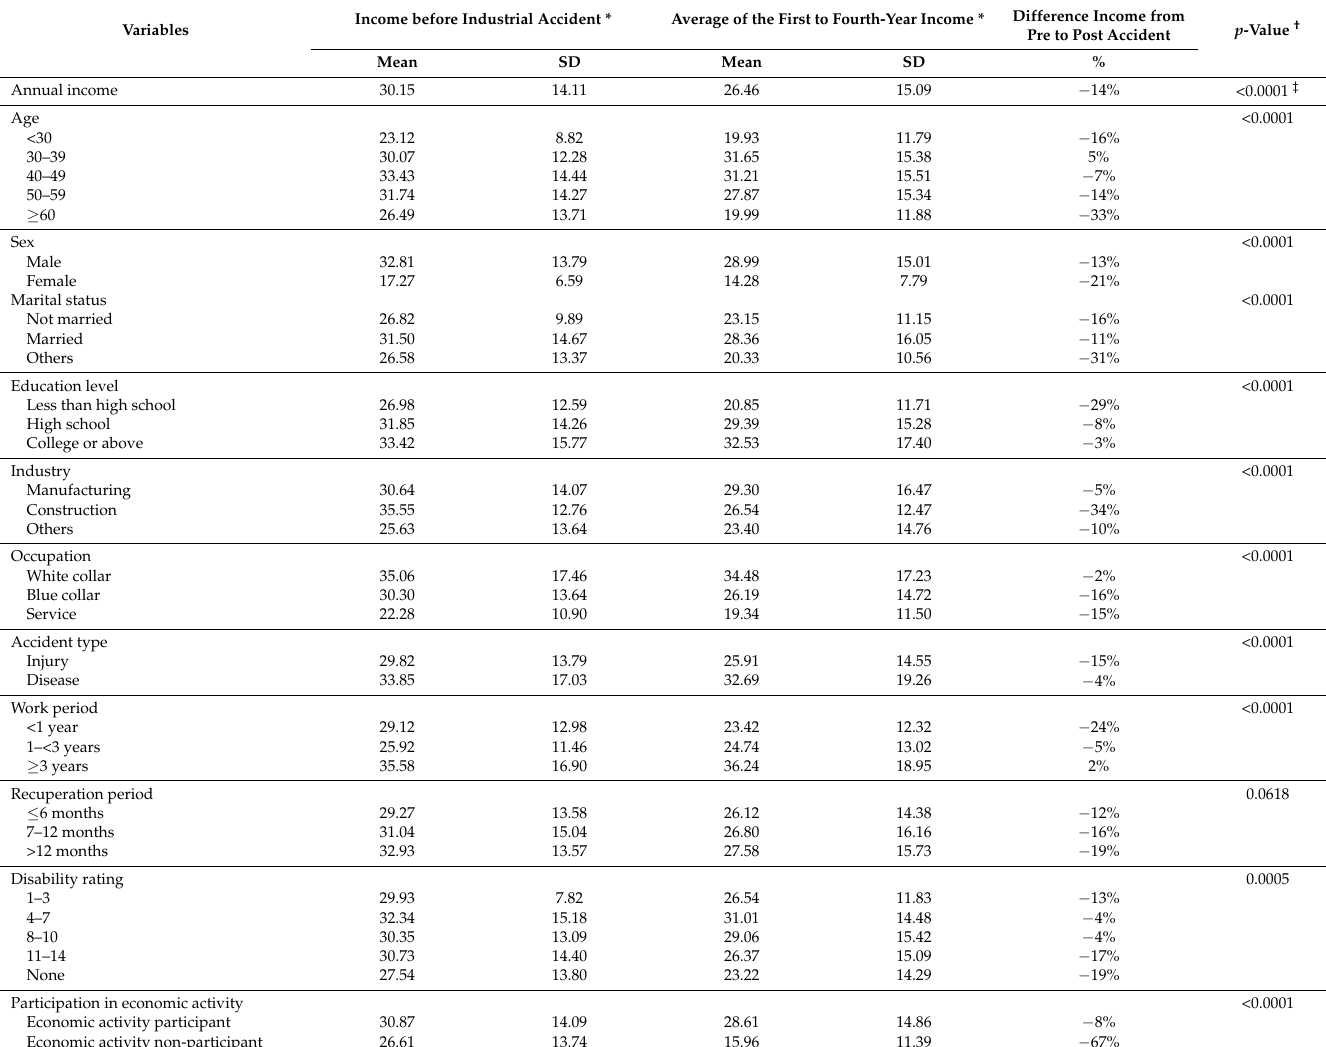
Table 4. Comparison of the income before industrial accident and the four-year average income after the industrial accident according to general characteristics (unit: million